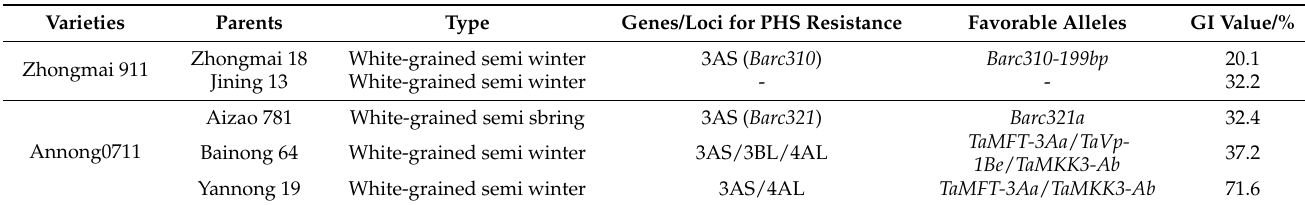
Table 4. The varieties developed by marker-assisted